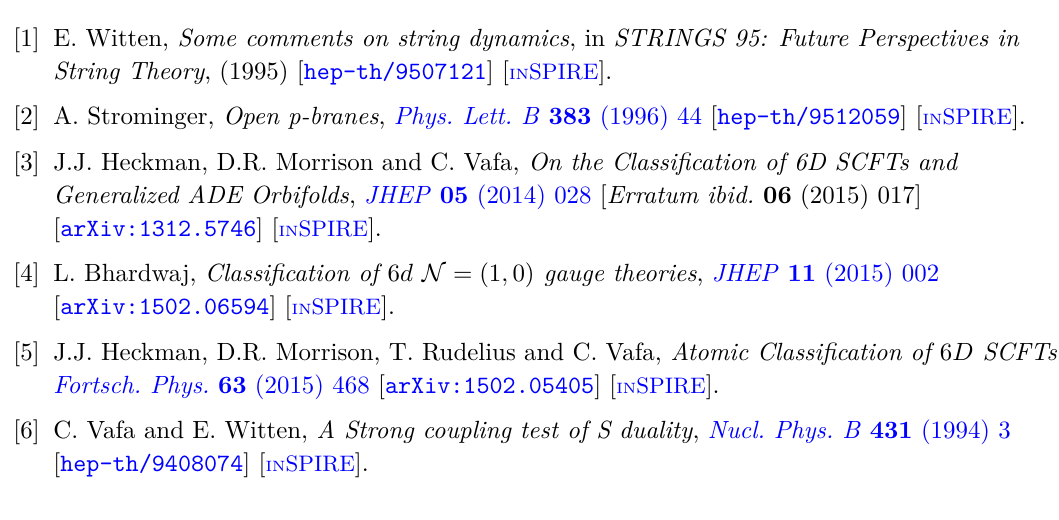
Figure 1 . The figure displays two regions in the 3d projective space of 6d anomaly polynomials in the affine chart where α 6 = 1 , parametrized by β/α, γ/α, δ/α . The red one is the region carved out by the inequalities (C.2). The blue one is the region given by condition that c almost all minimal surfaces of general type (meaning that we take χ and σ to be large that the inequalities (C.4) can be replaced by homogeneous